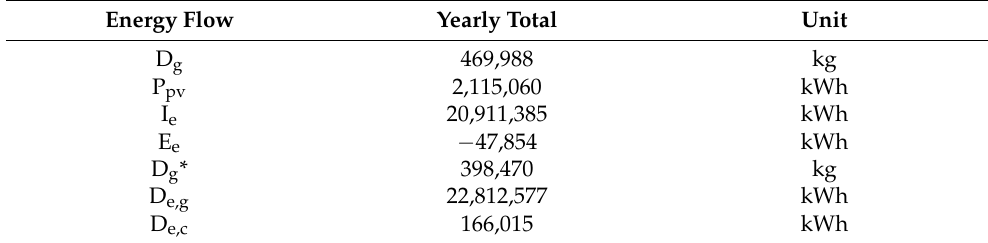
Table 5. Yearly totals of energy and hydrogen